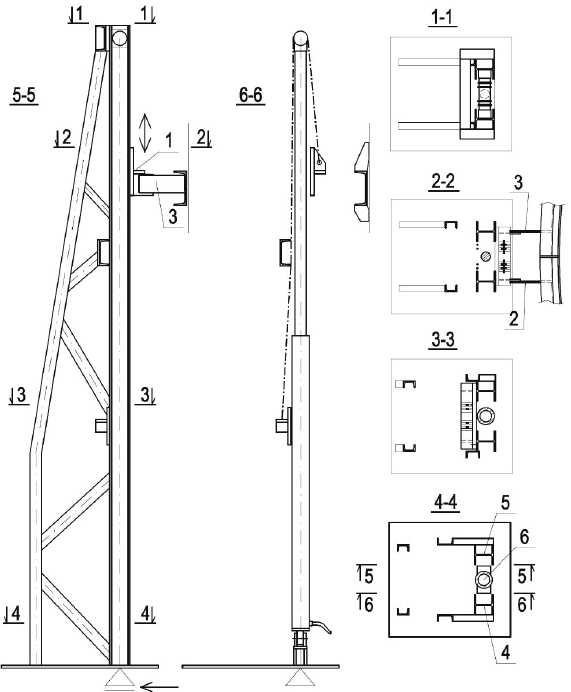
Figure 1: Layout of a tower used for tank assembly: 1, carriage (lifting chair); 2, connector A; 3, connector B; 4, chord A; 5, chord B; 6, jack